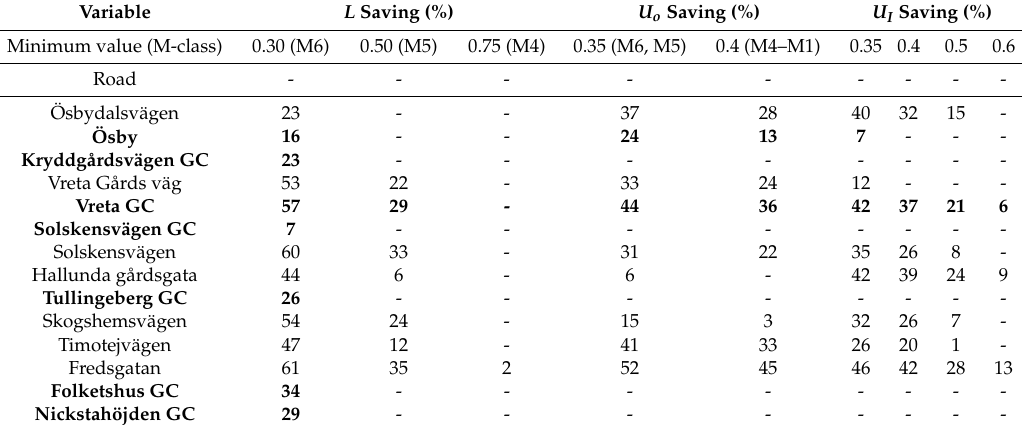
Table 4. Calculated saving (mean value in %) based on the limit for M-classes of average road surface luminance ( L , cd/m 2 ), overall luminance uniformity ( U o ) and longitudinal luminance uniformity ( U I ). The M-classes for U I differ between European and Swedish standards and are therefore not shown (but see Table 2). Negative values would have indicated road lighting below the limit of the class and are therefore not shown. “GC” and bold letters indicate pedestrian and bicycle roads.